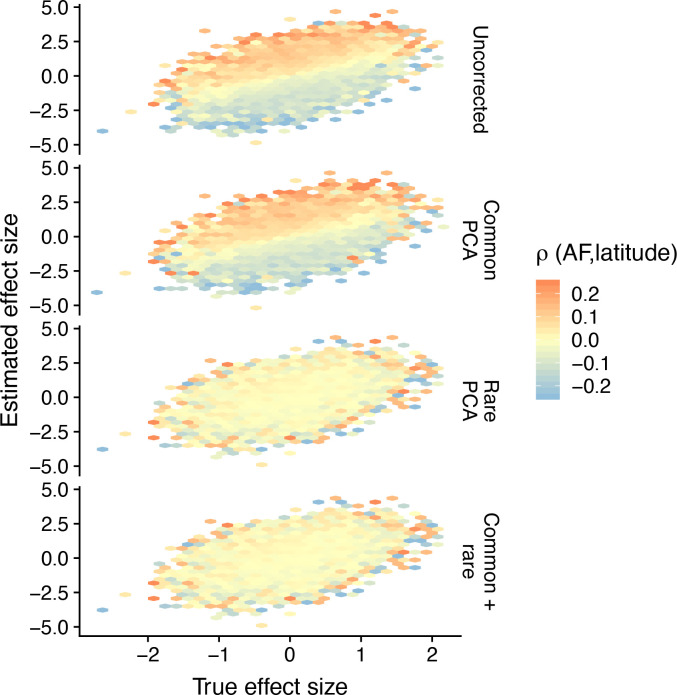
Hexagonal bin plots illustrating the residual confounding in variant effect sizes due to stratification.Each panel shows the comparison of the true (simulated) and estimated effect sizes of causal variants (M = 2000) for different modes of correction for population structure and when the environment is smoothly distributed in a North-South cline. The color of each bin represents the mean correlation of variants in that bin and latitude, averaged across 20 simulations. When there is residual stratification, the effect sizes of variants that are positively correlated with latitude are biased upwards, whereas the effect sizes of variants that are negatively correlated are biased downwards. Even though the effect size of any single variant may be biased due to stratification, the effect size across all variants is still unbiased. In this particular case, because the population structure has a recent origin, rare-PCA, but not common-PCA adequately removes the bias.